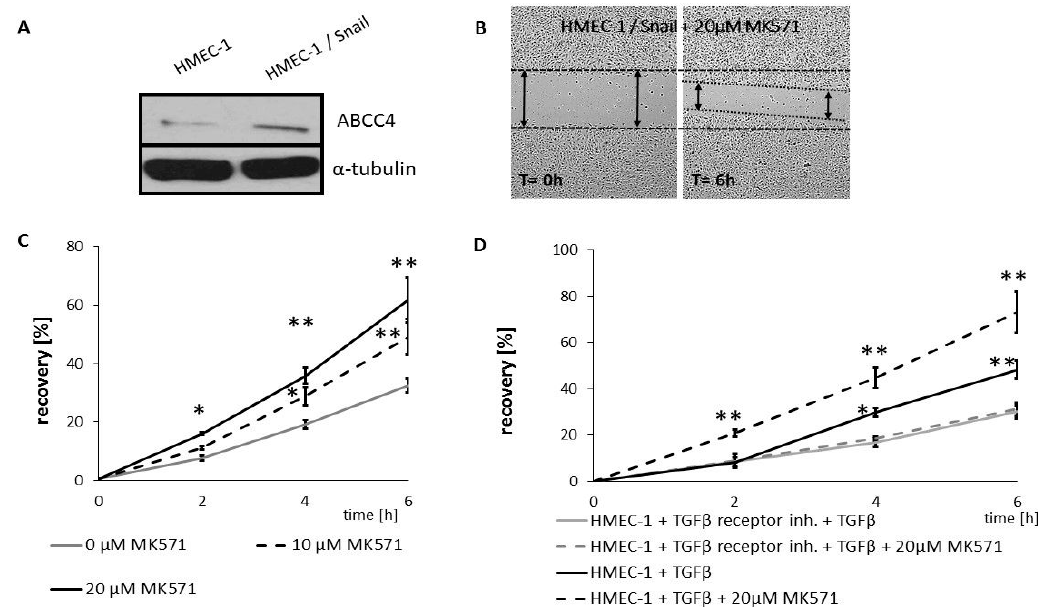
Figure 5. MK571 increased motility of EndoMT undergoing HMEC-1 cells. ABCC4 level in HMEC-1 and HMEC-1 overexpressing Snail cells (HMEC-1 / Snail). ( A ) HMEC-1 were grown to confluence on 6-well plate, and transiently transfected with pcDNA / Snail and wounded across monolayer as described in [31]. New medium containing MK571 was added. ( B ) Representative image of HMEC-1 control or HMEC-1 / Snail cells in wound healing assay. ( C ) Wounded area was visualized after 0, 2, 4 and 6 h using Nikon Eclipse TE 2000-U microscope (Nikon, Japan) and calculated by ImageJ software [32]. Cell motility was estimated through the quantification of the % of recovery using the equation: R(%) = [1 − (wound area at Tt / wound area at T0)] × 100,where T0 is the wounded area at 0 h and Tt is the wounded area after 2 or 4 h. * p < 0.05; ** p < 0.005; n = 3. ( D ) HMEC-1 treated w / wo TGF- β receptor inhibitor were grown to confluence on 6 well plate, incubated for 48 h with 10ng / mL TGF- β 2 in starving condition as described in [31 and wounded. Wounded area was visualized and analyzed as in ( C